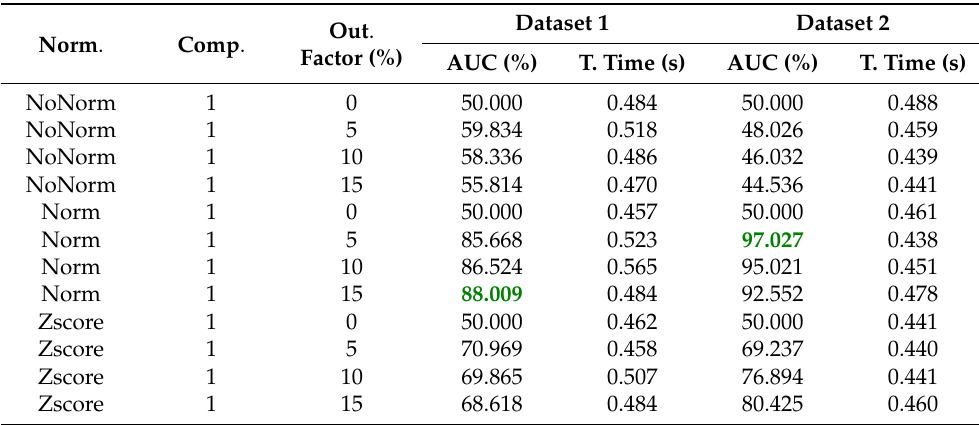
Table 4. PCA results for dataset 1 and 2.